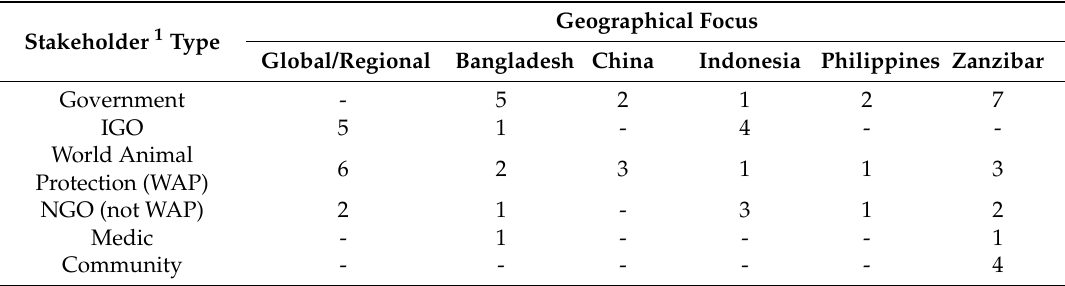
Table 1. Breakdown of stakeholder type and geographical